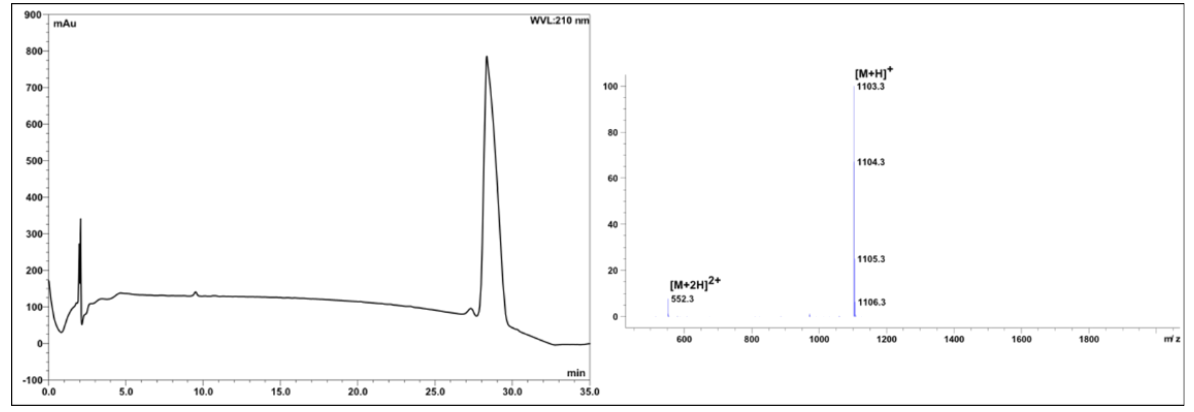
Figure 3. Analytical RP-HPLC profile of the simplified trichoderin A analogue ( 4 ) (>99% purity as judged by peak area at 210 nm); xTerra ® MS C18, 4.6 × 150 mm, 5 µm, linear gradient of 5% to 95% B (ca. 3% B min −1 ), flow rate 1 mL min −1 . ESI-MS m / z [M + H] + calculated: 1103.6; found: 1103.3. (ca. 3% B min − 1 ), flow rate 1 mL min − 1 . ESI-MS m / z [M + H] + calculated: 1103.6; found: